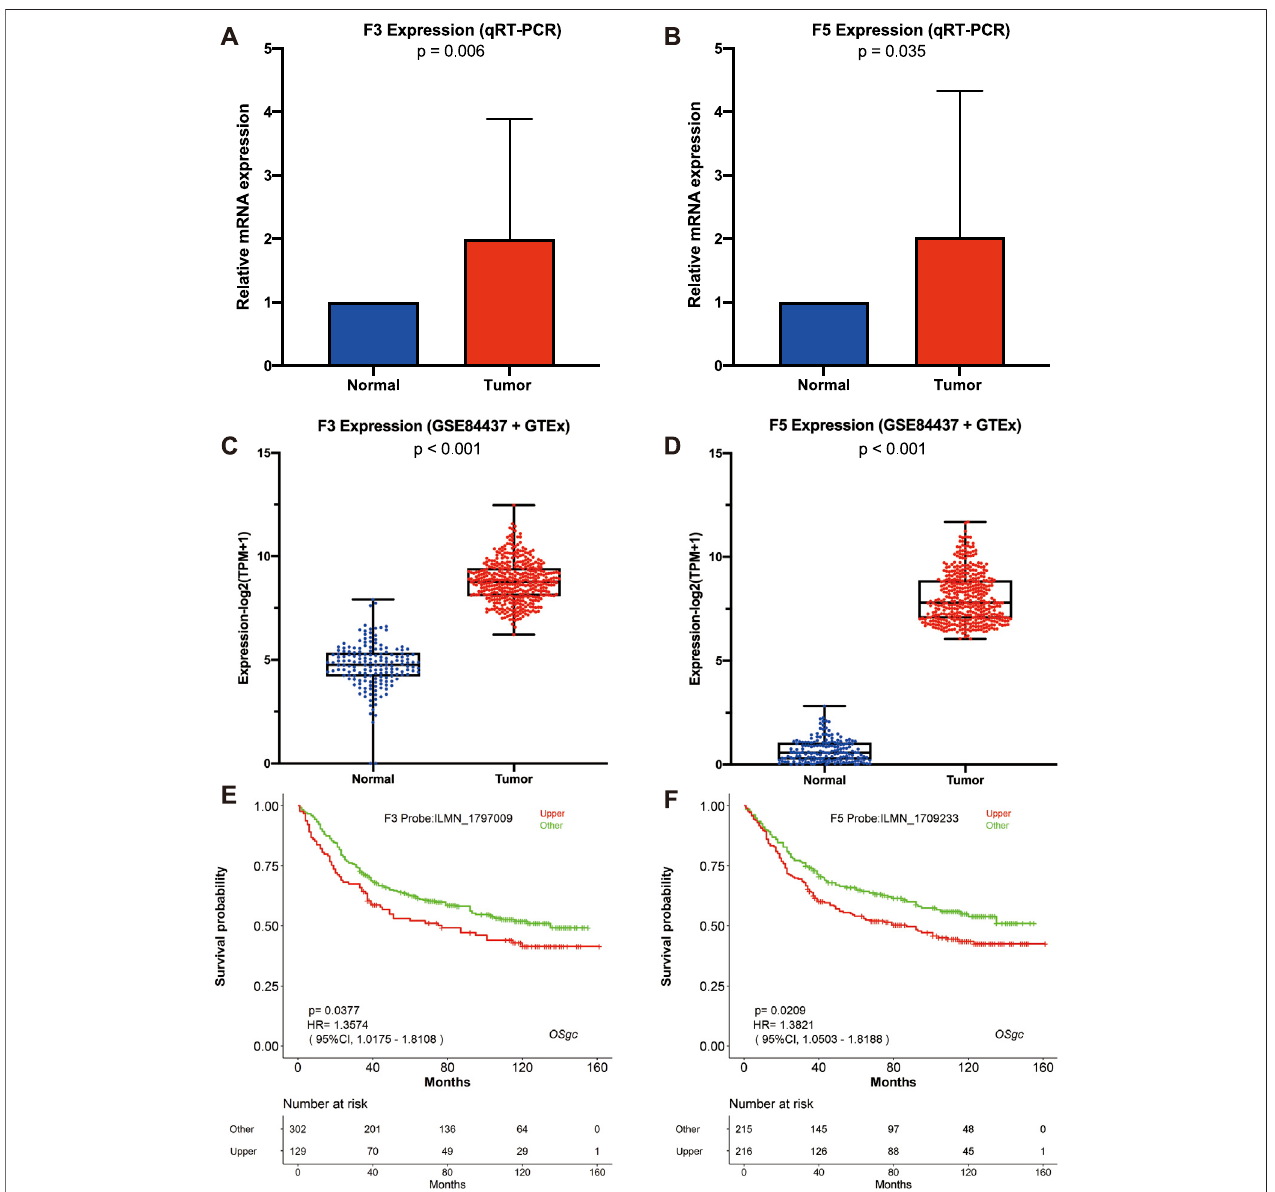
FIGURE6| ValidationofF3andF5 ’ sbiomarkerpotential via qRT-PCRandGEOcohort. (A – B) F3andF5expressioncomparedwithinnormalandtumortissues via qRT-PCR. (C – D) ComparisonofF3andF5expression vi aGEO-GSE84437andGTExdata. (E – F) Kaplan-MeierplotsofF3andF5usingGSE84437data,generated via